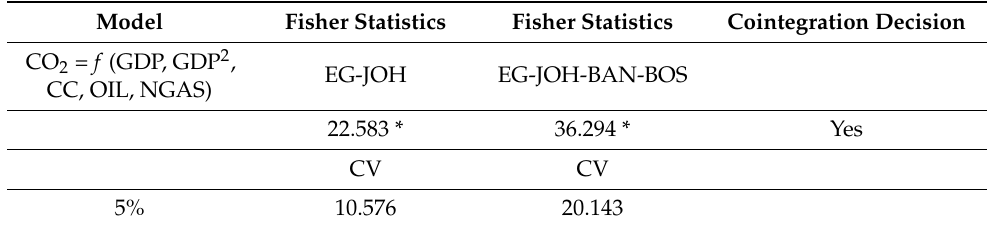
Table 5. Bayer–Hanck cointegration